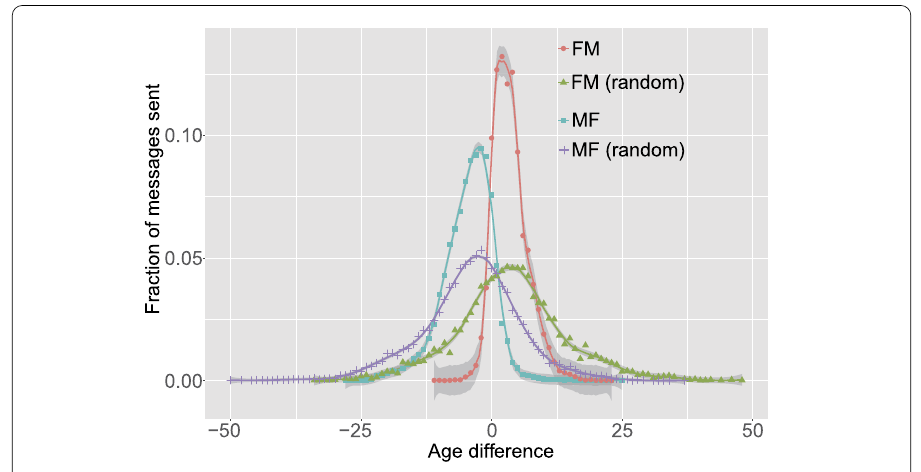
Figure 1 Age difference distribution. FM represents that female users send messages to male users and MF represents that male users send messages to female users. Solid lines represent the locally weighted polynomial regression fitting of their corresponding data points, and the gray interval represents a 95% confidence